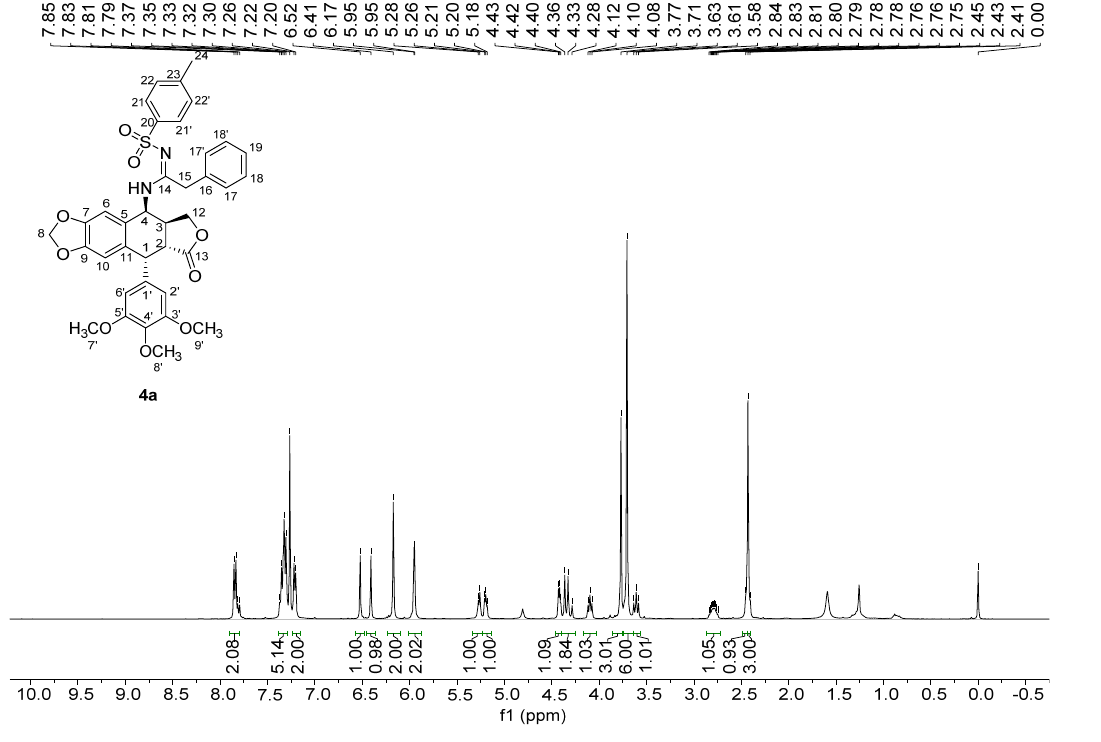
Figure 3. 1 HNMR spectra of 4a